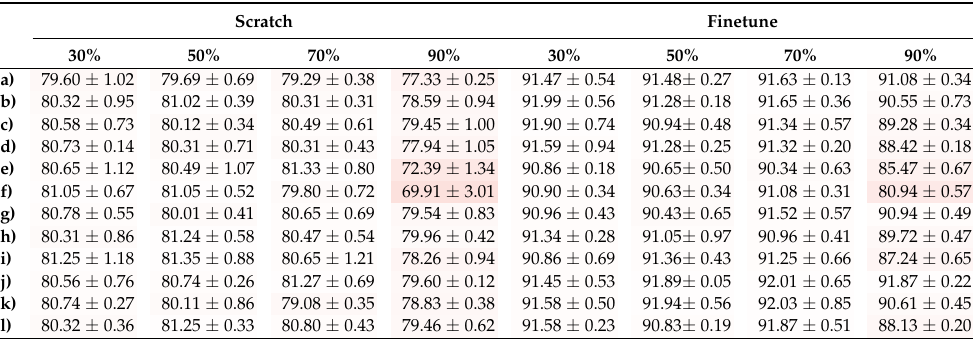
Table 4. Results of sparsifying ResNet-18 for all available criteria. Granularity, context and criteria are respectively set to weight, local and large_final. Mean and standard deviation of accuracy over 3 rounds are reported. The darker the shade of red, the further the accuracy is from the